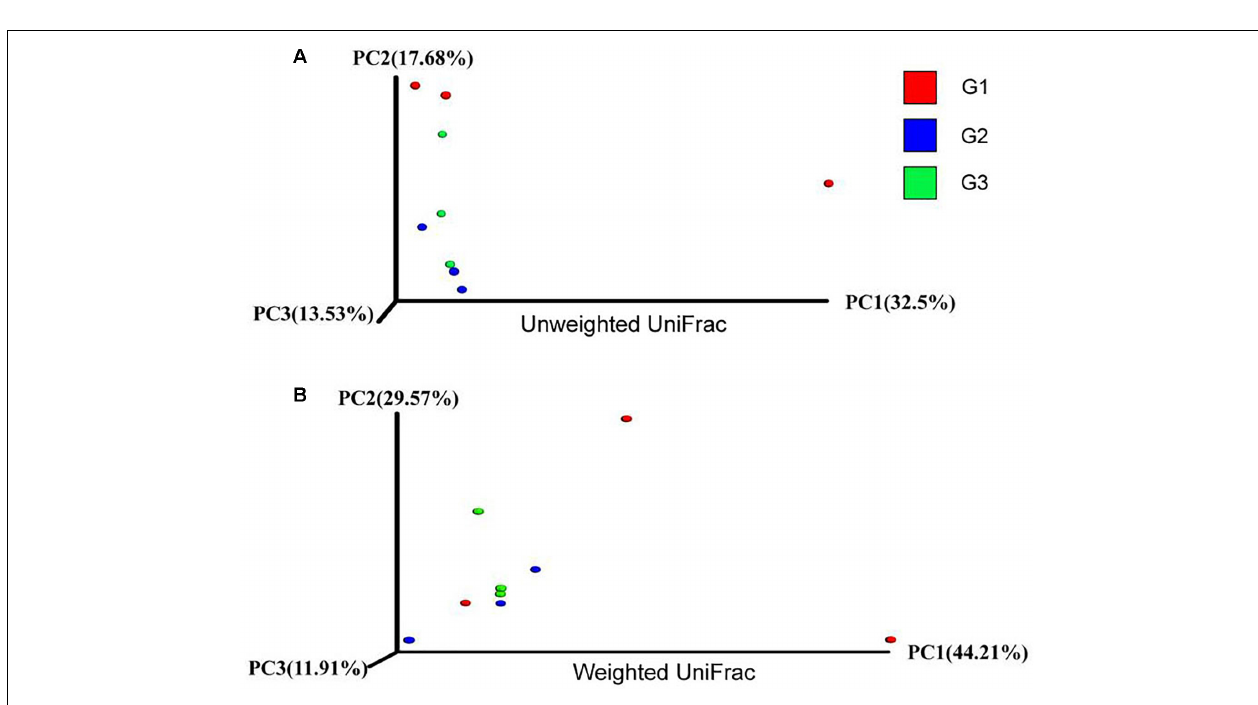
FIGURE 7 | Effects of Ba on α -diversity of microbial population in piglets. Shannon (A) , Chao1 (B) , PD whole tree (C) , and observed species (D) was analyzed.